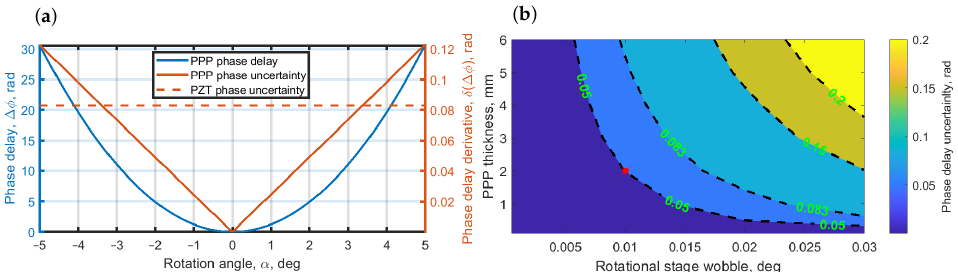
Figure 3. Phase-shift precision estimation in PPP and PZT. ( a ) Left y -axis is for the phase delay; right y -axis is for the phase delay uncertainty. The solid blue curve is the phase delay in the rotated PPP, the solid orange curve is the uncertainty of the phase delay in the PPP, and the dashed orange line is the uncertainty of PZT. ( b ) Rotated PPP phase delay uncertainty map for delay value of ( 3 π /2 + 1 ) rad depending on PPP thickness and rotational stage wobble. Red dot corresponds to the considered MTS wobble of 0.01 deg and PPP thickness of 2